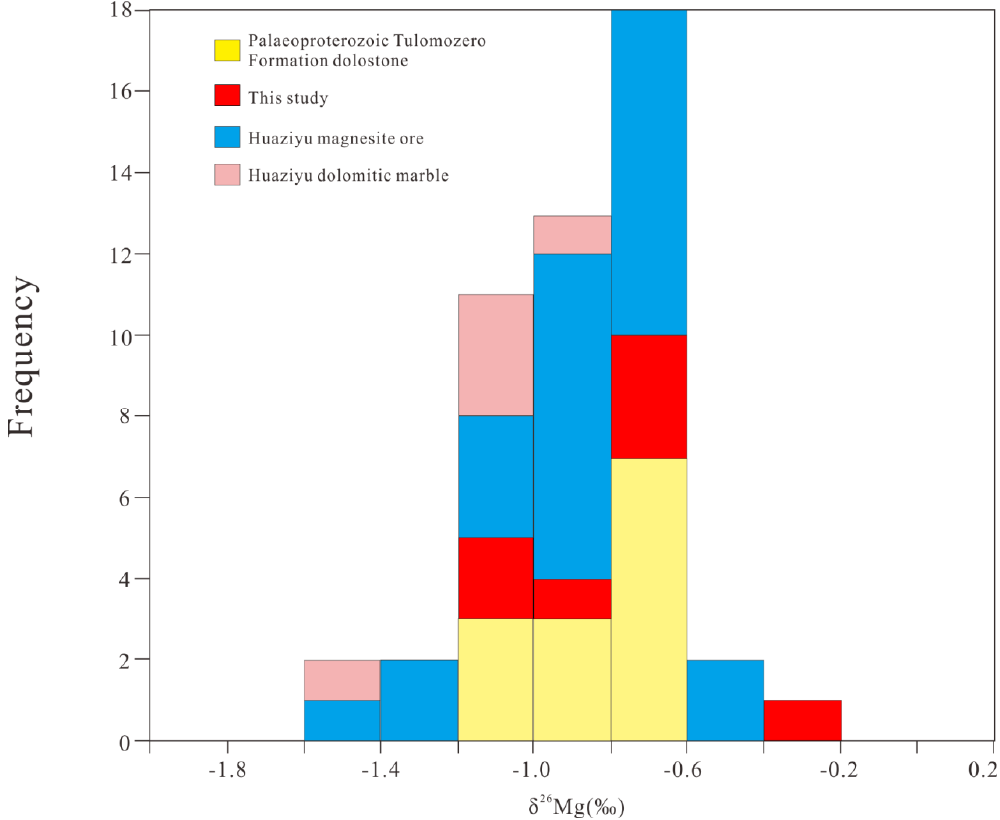
Figure 9. Histogram showing the δ 26 Mg variations of the Zhaoanzhuang iron deposit (in this study) along with other published data for the sedimentary dolomites in the Palaeoproterozoic Tulomozero formation in the Onega Basin, southeastern Fennoscandian Shield, Russia [55] and the Huaziyu magnesites in the Palaeoproterozoic Lieryu formation in the Liaohe Group, northeastern North China Craton, China [145].